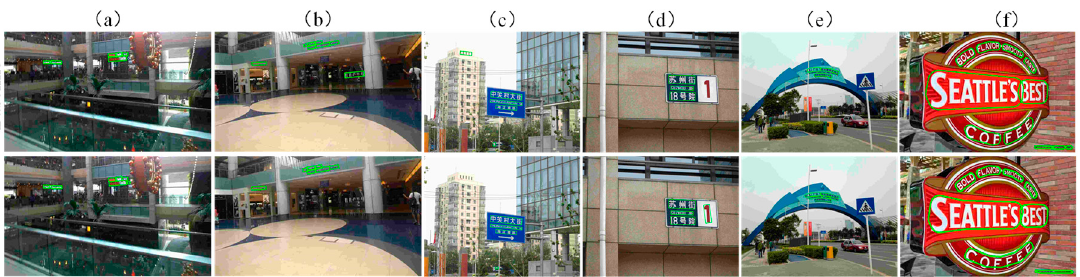
Figure 7. Visualization results display on different types of text examples. Where ( a , b ) are multi- directional texts, ( c , d ) are multi-lingual texts, ( e , f ) are curved texts. directional texts, ( c , d ) are multi-lingual texts, ( e , f ) are curved